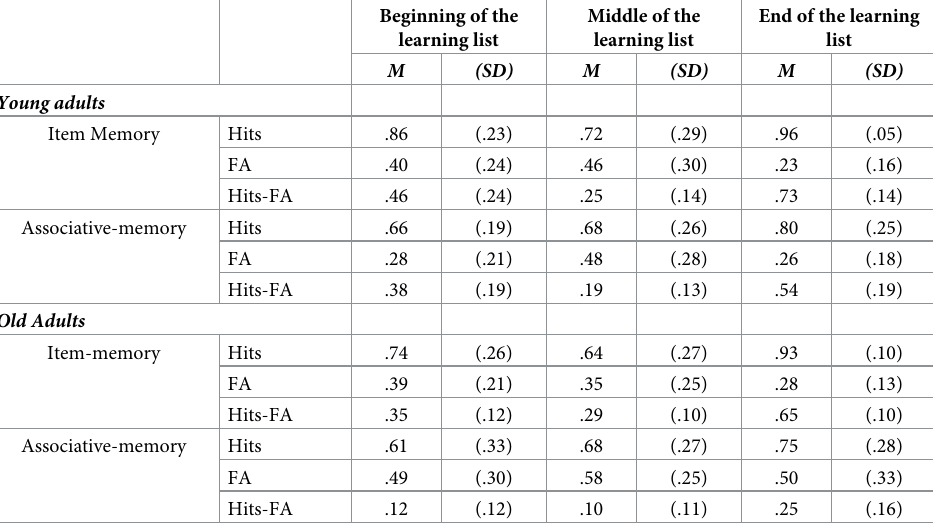
Table 3. Means and standard deviations for Hits and False Alarms (FA) for item and associative recognition as a function of age and SSP.